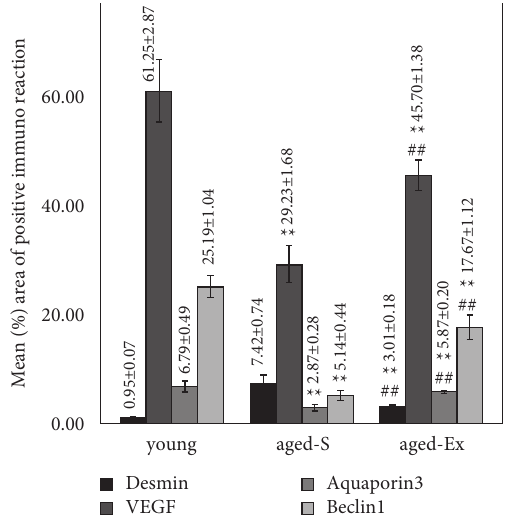
Figure 9: The histogram denoting the mean % area of positive desmin, VEGF, aquaporin-3, and beclin-1 immunoreactivity in the young, aged-S, and aged-Ex groups. ∗∗ indicates P < 0 . 001 com- pared with the young group; ## indicates P < 0 . 001 compared with the aged-S group. The data expressed in mean ± SD ( n �